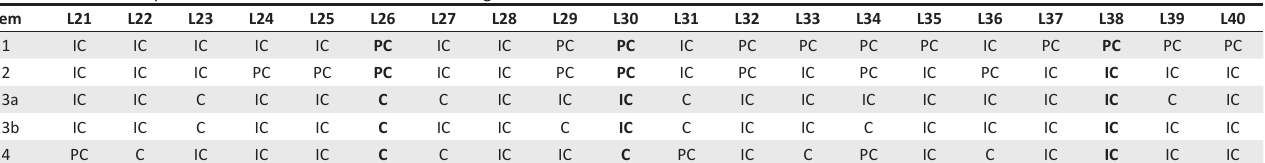
TABLE 1b: Learner responses to test items 1.1 to 1.4 in three categories.